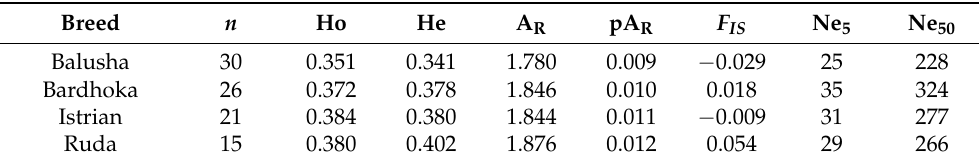
Table 1. Genetic diversity (LD = r 2 > 0.5) and effective population size of breeds analyzed in this study.